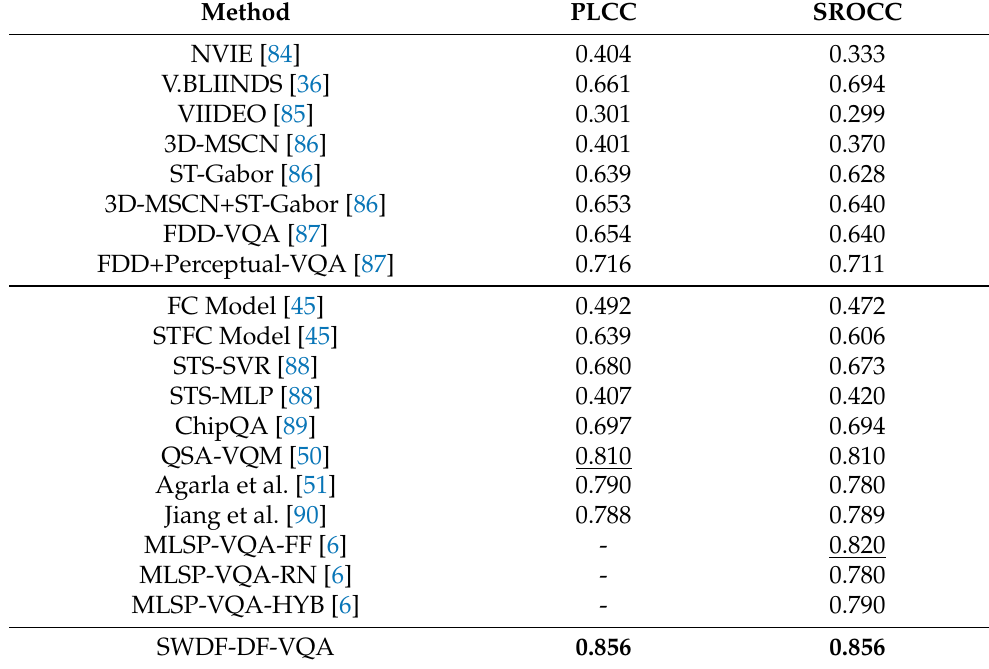
Table 9. Comparison of SWDF-DF-VQA to the state-of-the-art on KoNViD-1k [7]. Median PLCC and SROCC values were measured over 1000 random train–test splits. The best results are in bold, while the second best results are